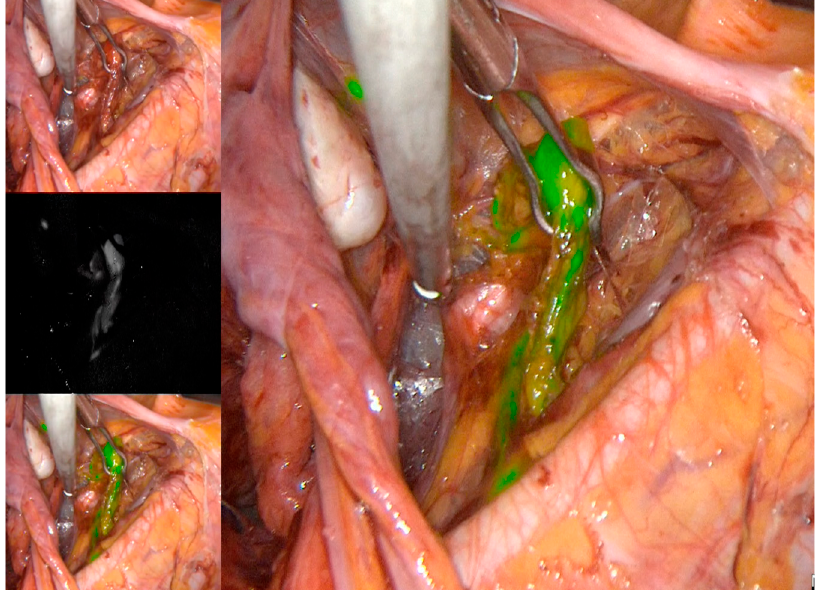
Figure 1. Anterior paracervical (sub-ureteral) pathway of lymphatic spread explored with ICG and near infra-red (NIR) camera of PINPOINT system in laparoscopic approach.